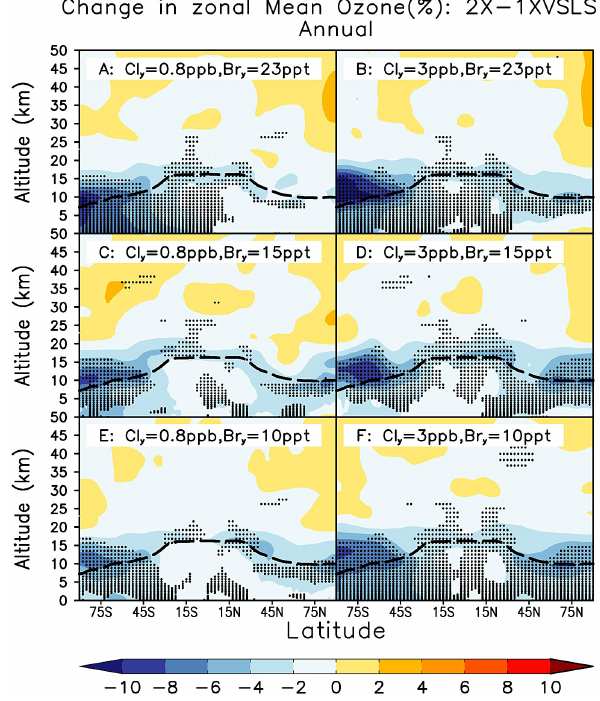
Figure 1. Relative ozone changes (in %) arising from doubling VSL emissions under 0.8ppbCl y (left column) and 3ppbCl y (right col- umn). The base case Br y concentrations (with 1 × VSLS, represent- ing 5ppt of the total Br y ) increase from the bottom to the top row, as indicated in the panels. The dotted regions represent statistically significant signals on a confidence level above 95%, as calculated by a student’s t